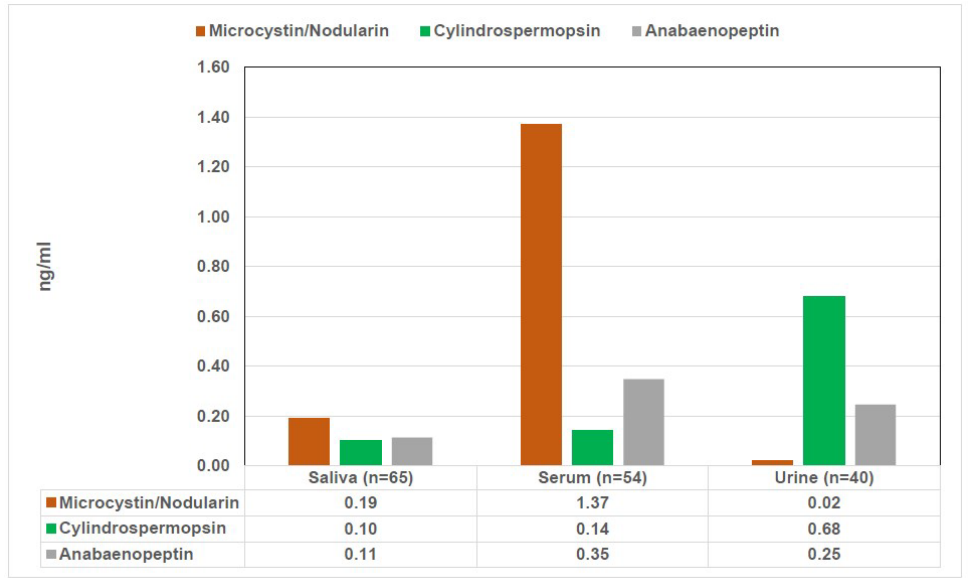
Figure 1. Cyanotoxin levels in human biospecimens.